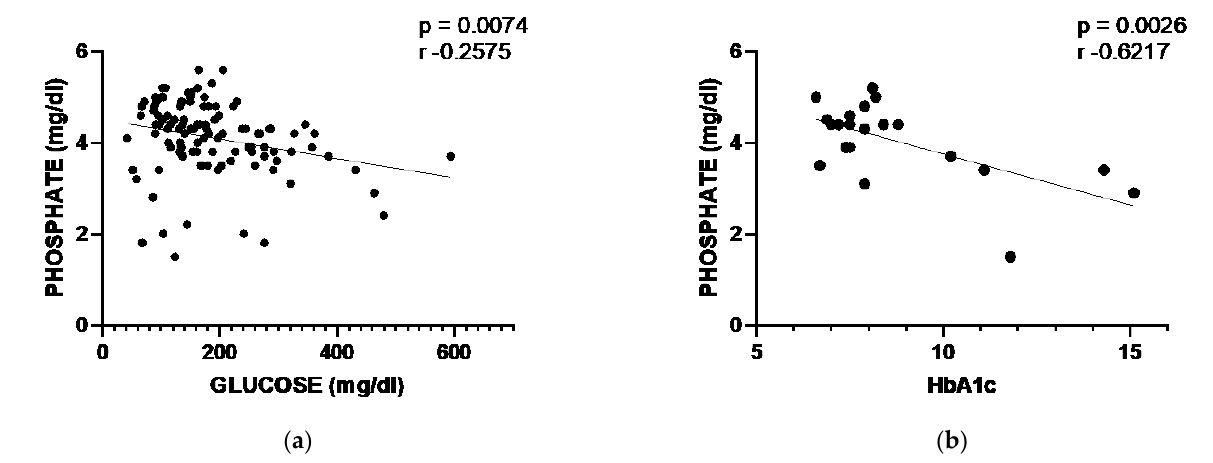
Figure 4. ( a ) Phosphorus-glucose correlation and ( b ) phosphorus-HbA1c correlation.